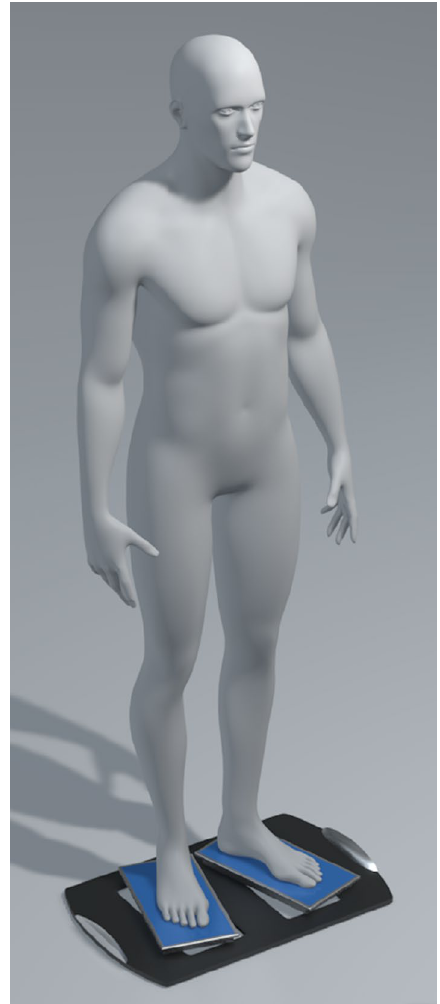
Figure 3. Body position during the postural control measurements. Volunteers stood eyes opened, arms by their side and feet positioned at a 30° angle, specifically located following the landmarks engraved on the